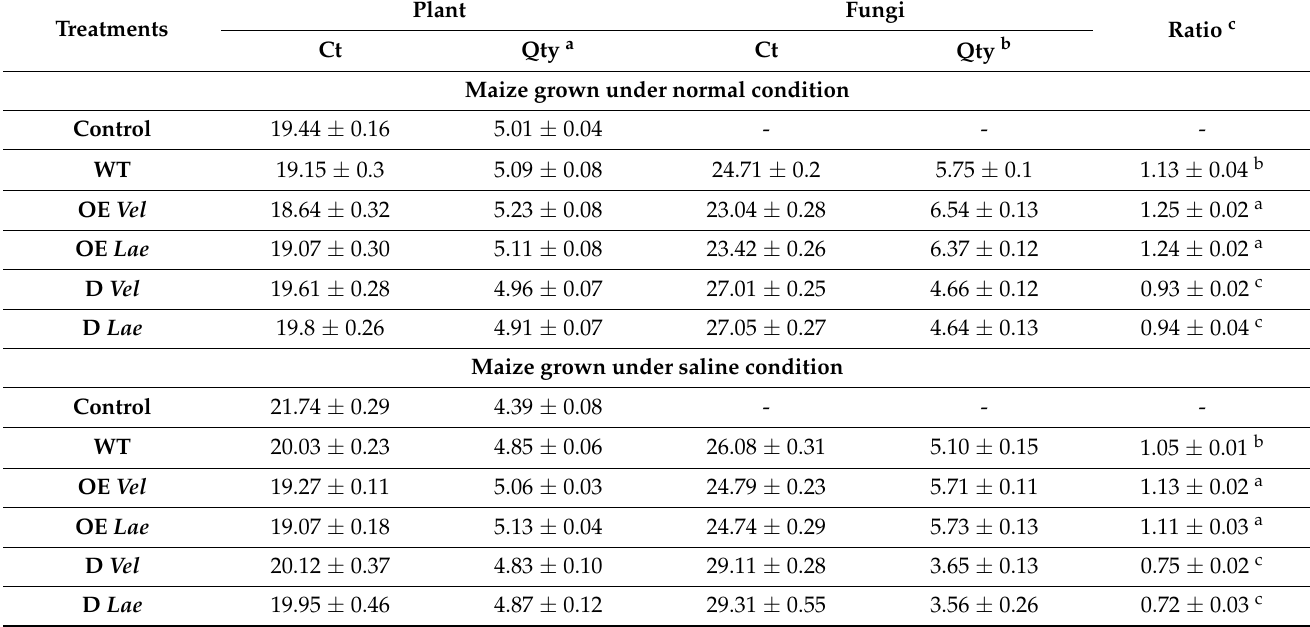
Table 1. Maize root fungal colonization by T. asperellum WT, OE Vel1 , OE Lae1 , ∆ Vel1 , and ∆ Lae1 strains under normal and saline conditions in a hydroponics